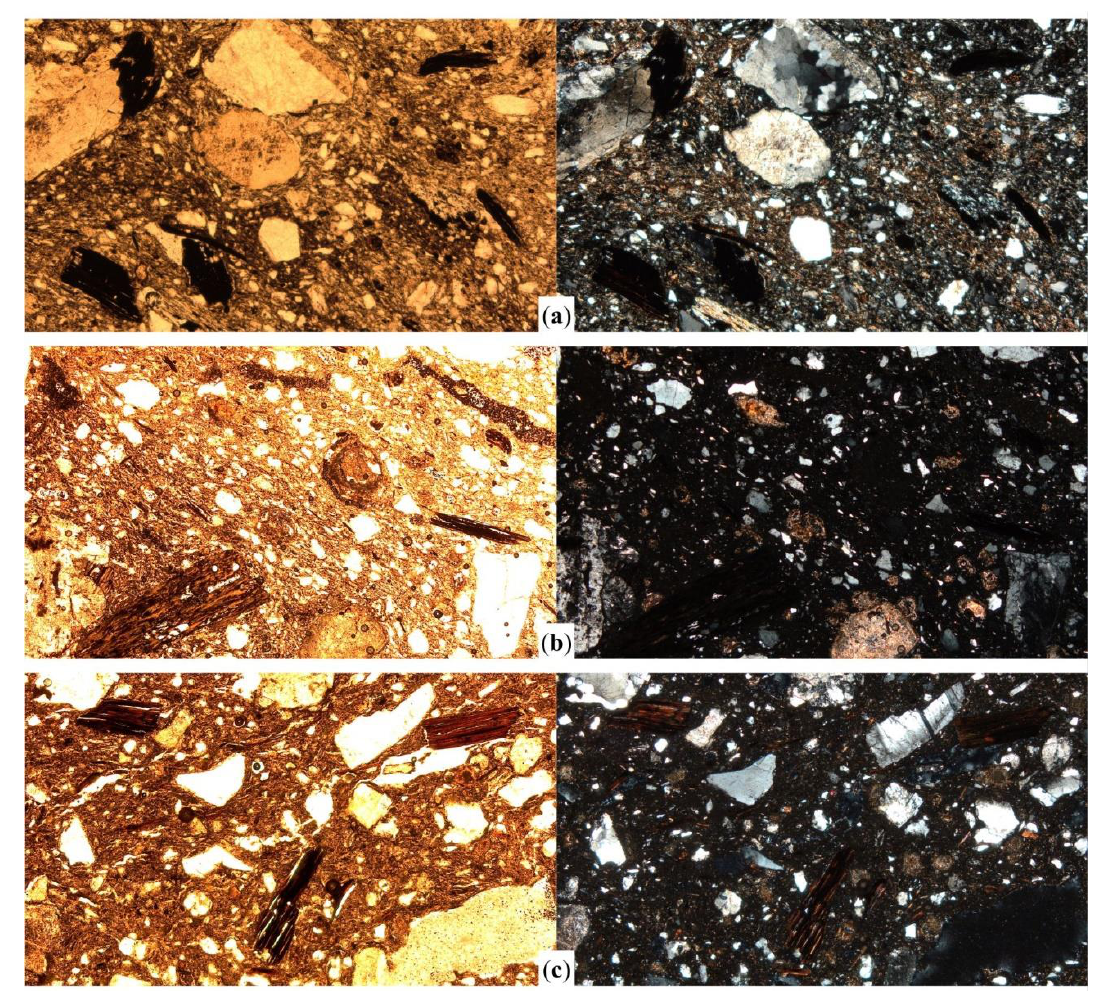
Figure 6. Photomicrographs of the selected samples with an estimated range of firing temperatures above 900 °C showing the main features of biotite inclusions. Sample SCO02 has an estimated temperature range of 900–950 °C, and shows moderately open cleavage in biotite and low pleochroism ( a ); samples SPM20 ( b ) and CR02 ( c ) were fired above 950 °C and show more altered features in biotite. All the images were captured in plane polarized light (left column) and crossed polars (right column), at 40× magnification. Image width = 3 mm.